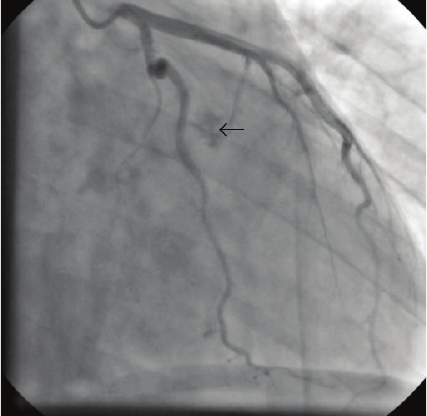
Figure 2: Right anterior caudal view of left coronary angiography showed delayed vascular blush (arrow) indicating a vascular mass which was fed from septal branches of left anterior descending artery.